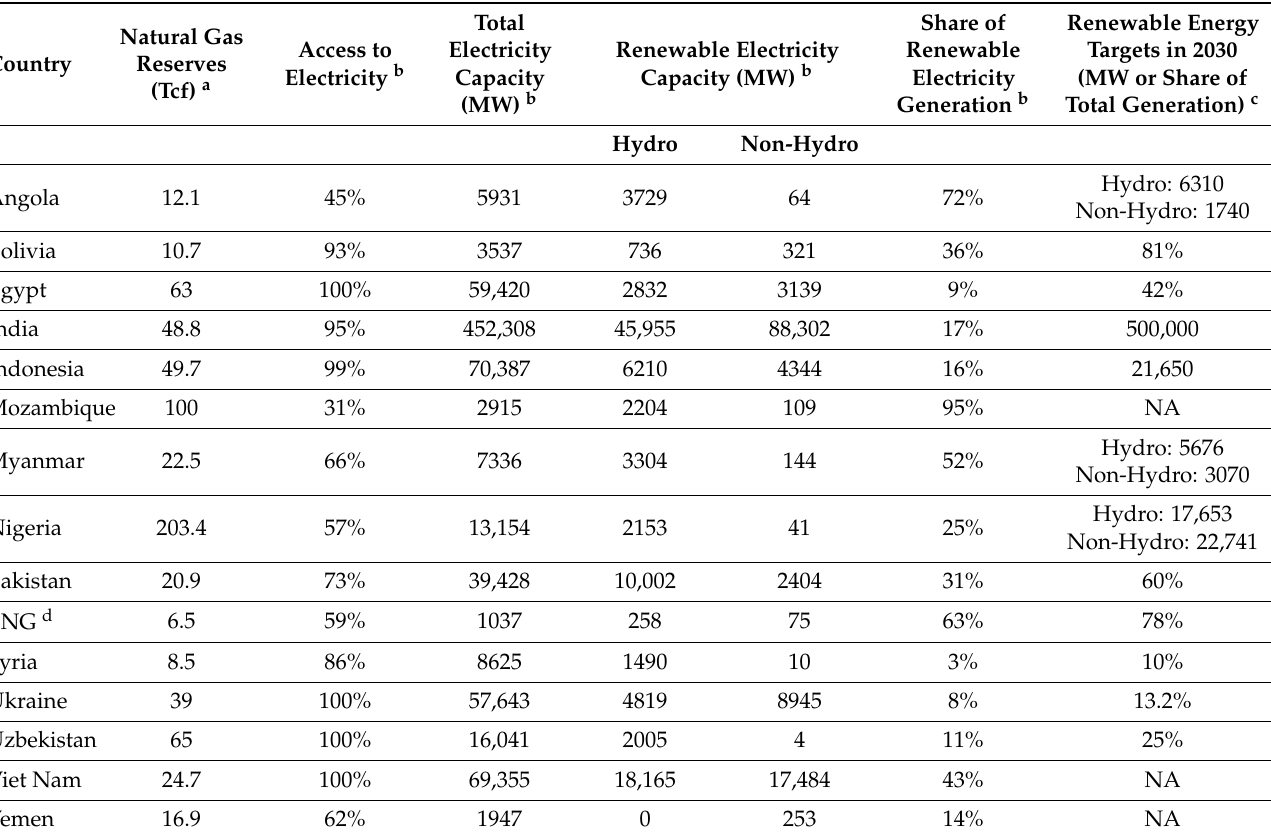
Table 1. Overview of the current status and future renewable energy targets in the electricity sector of lower-income countries possessing natural gas